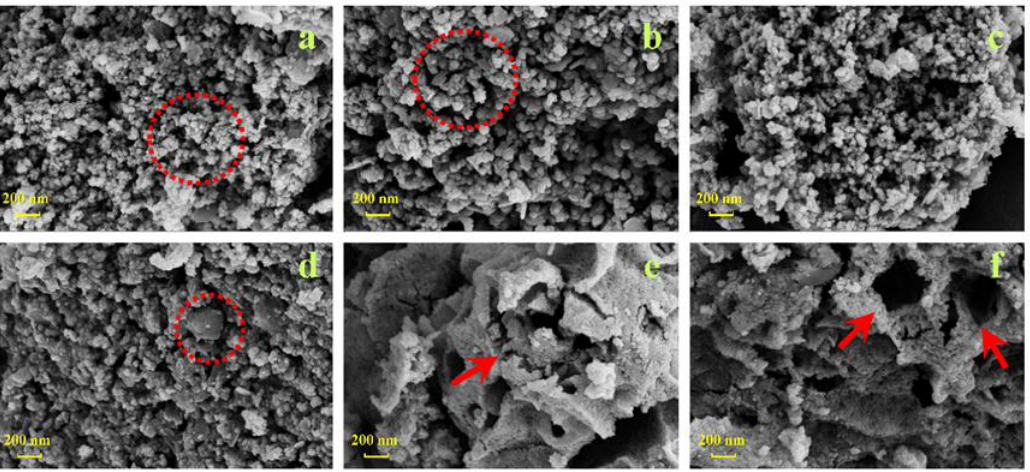
Figure 5. SEM images of titanium modified FeMgO x catalysts with different precursors: ( a ) SN, ( b ) SS, ( c ) CN, ( d ) CS, ( e ) NN and ( f ) NS.